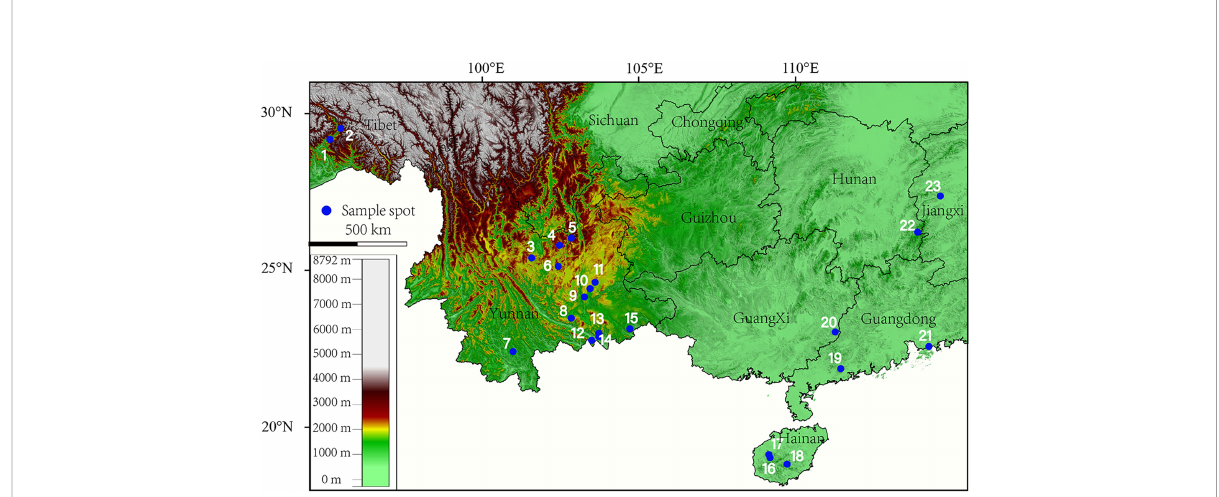
FIGURE 1 Sampling spots of specimens used in this study (1: Quercus kiukiangensis ; 2: Quercus lamellosa ; 3: Lithocarpus dealbatus ; 4: Quercus schottkyana, Quercus variabilis, Quercus serrata, Quercus aliena, Lithocarpus elizabethiae, Castanea seguinii, Castanopsis orthacantha ; 5: Lithocarpus craibianus ; 6: Quercus longispica ; 7: Quercus rex ; 8: Lithocarpus mairei ; 9: Quercus franchetii ; 10: Quercus cocciferoides ; 11: Quercus argyrotricha ; 12: Lithocarpus gymnocarpus ; 13: Lithocarpus pachylepis ; 14: Quercus augustinii, Lithocarpus xylocarpus ; 15: Quercus marlipoensis, Lithocarpus balansae, Lithocarpus c.f. annamitorus, Lithocarpus bacgiangensis, Lithocarpus longinux, Lithocarpus sp.1 ; 16: Quercus patelliformis, Lithocarpus longipedicellatus ; 17: Quercus fl euryi, Lithocarpus fenzelianus ; 18: Lithocarpus sp.2 ; 19: Lithocarpus longanoides ; 20: Quercus blakei, Quercus phanera, Quercus kouangsiensis ; 21: Quercus litseoides, Quercus sessilifolia ; 22: Lithocarpus skanianus ; 23: Quercus gilva